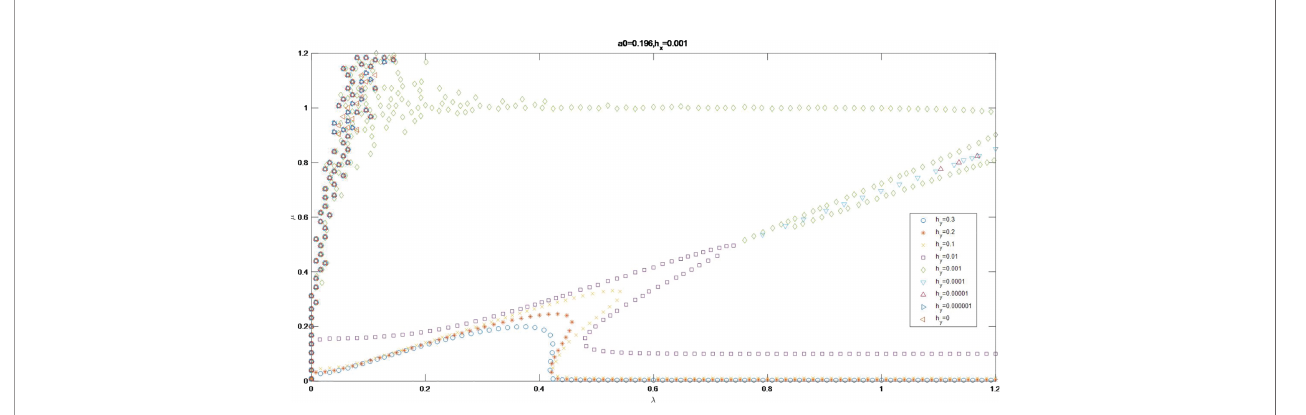
FIGURE 8 | The magni fi ed curves of Im W = 0 for a 0 = 0.196 and ∂ h ∂ x = 0 :